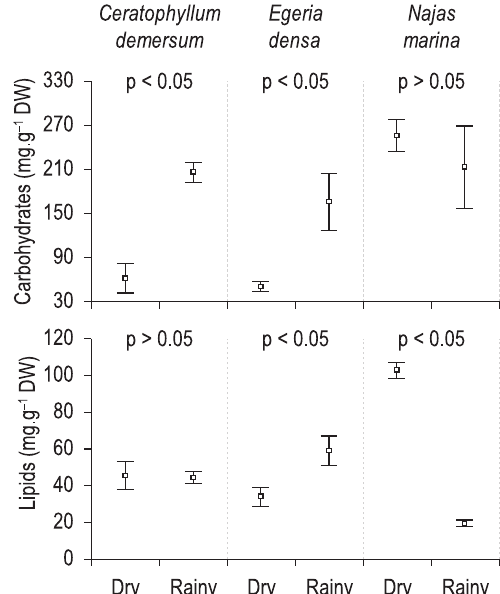
Figure 5. Soluble carbohydrates and lipids in Ceratophyllum dermesum , Egeria densa and Najas marina in Campelo Lagoon in dry (July/2001) and rainy (January/2002) season. The vertical bars represent the standard deviation; p : significance